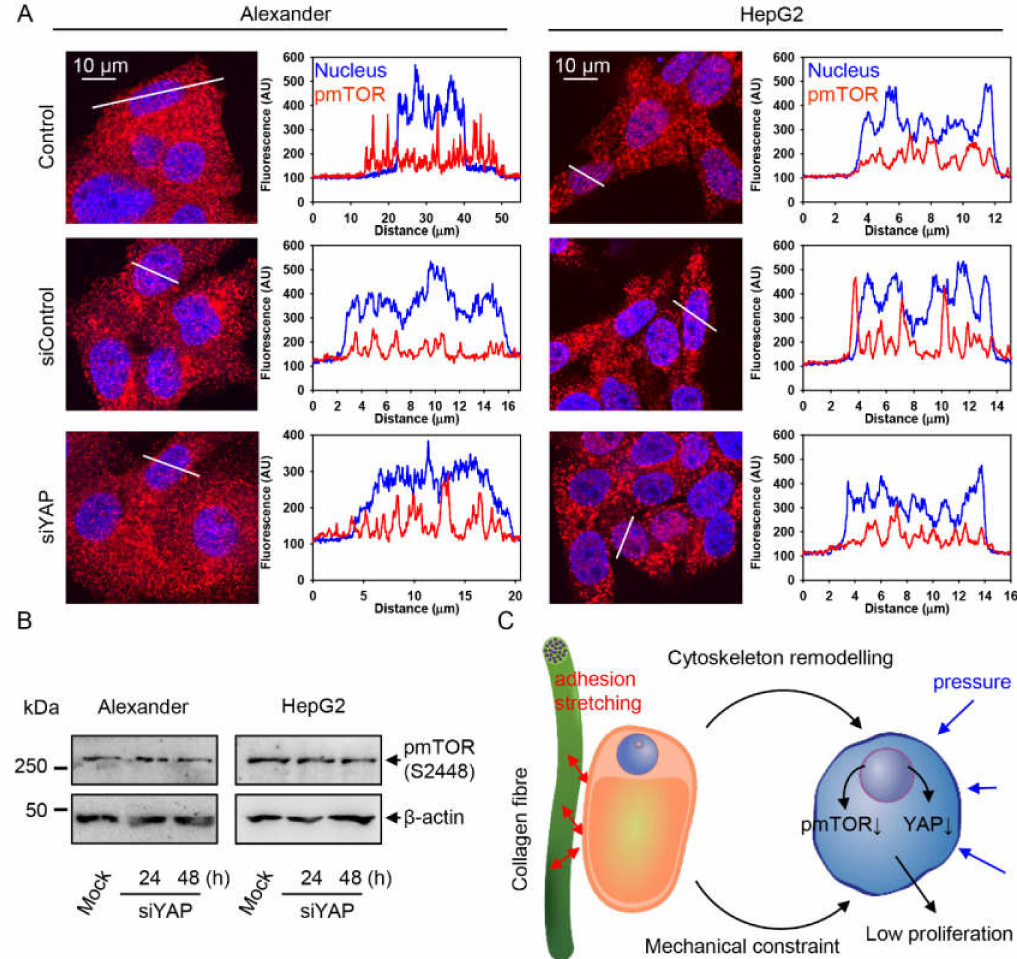
Figure 7. YAP downregulation does not change pmTOR signaling. ( A ) Immunostaining analysis for pmTOR (red) in Alexander and HepG2 cells transfected with YAP siRNA for 48 h. Hoechst 33342 (blue) dye was used to counterstain nuclei. Labeled cells were then imaged by confocal microscopy and the imaged were processed using ImageJ software (NIH). Representative confocal microscopic images and line scans. ( B ) Immunoblot analysis for pmTOR in Alexander and HepG2 cells transfected with YAP siRNA for 24 and 48 h; β -actin—control of equal protein loading. ( C ) Scheme of competing mechanical cues, i.e., adhesion and pressure, that cells experience in collagen sca ff olds. Mechanistic explanation of signaling events modulated by mechanical cues; ↓